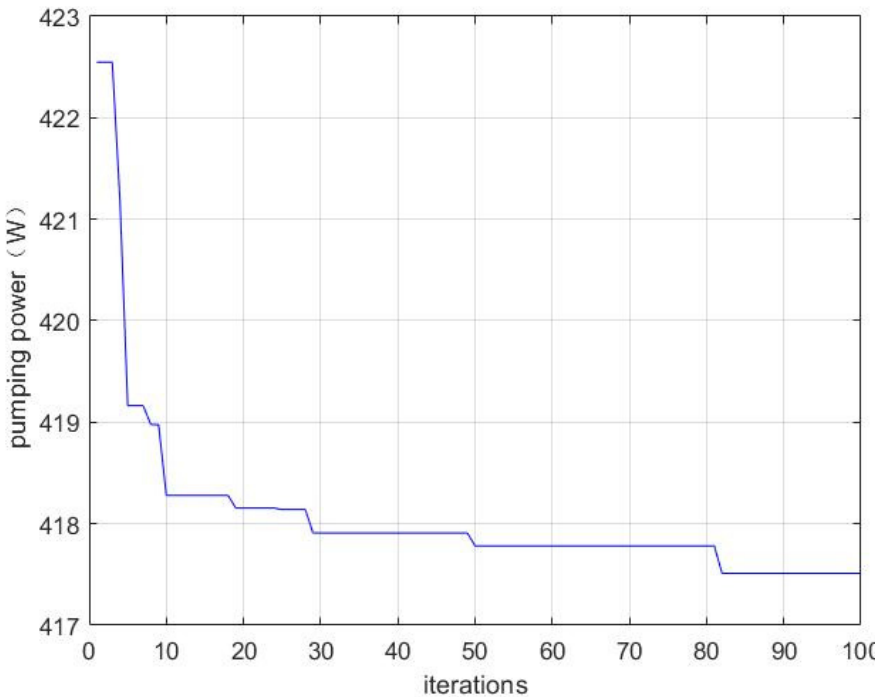
Figure 9. Running results of optimal ice concentration algorithm. Table 3. C, Q, and P data of different